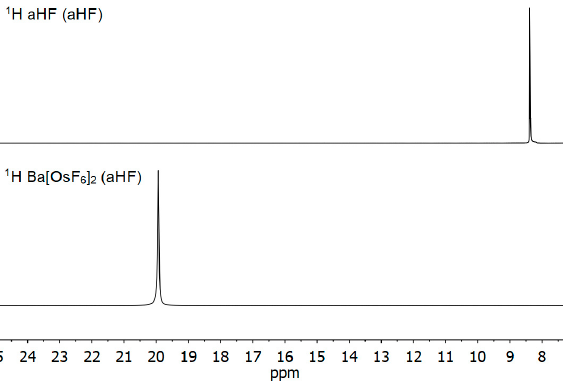
Figure 4. 1 H NMR spectra of neat anydrous HF (top) and anhydrous HF with Ba(OsF 6 ) 2 (bottom).